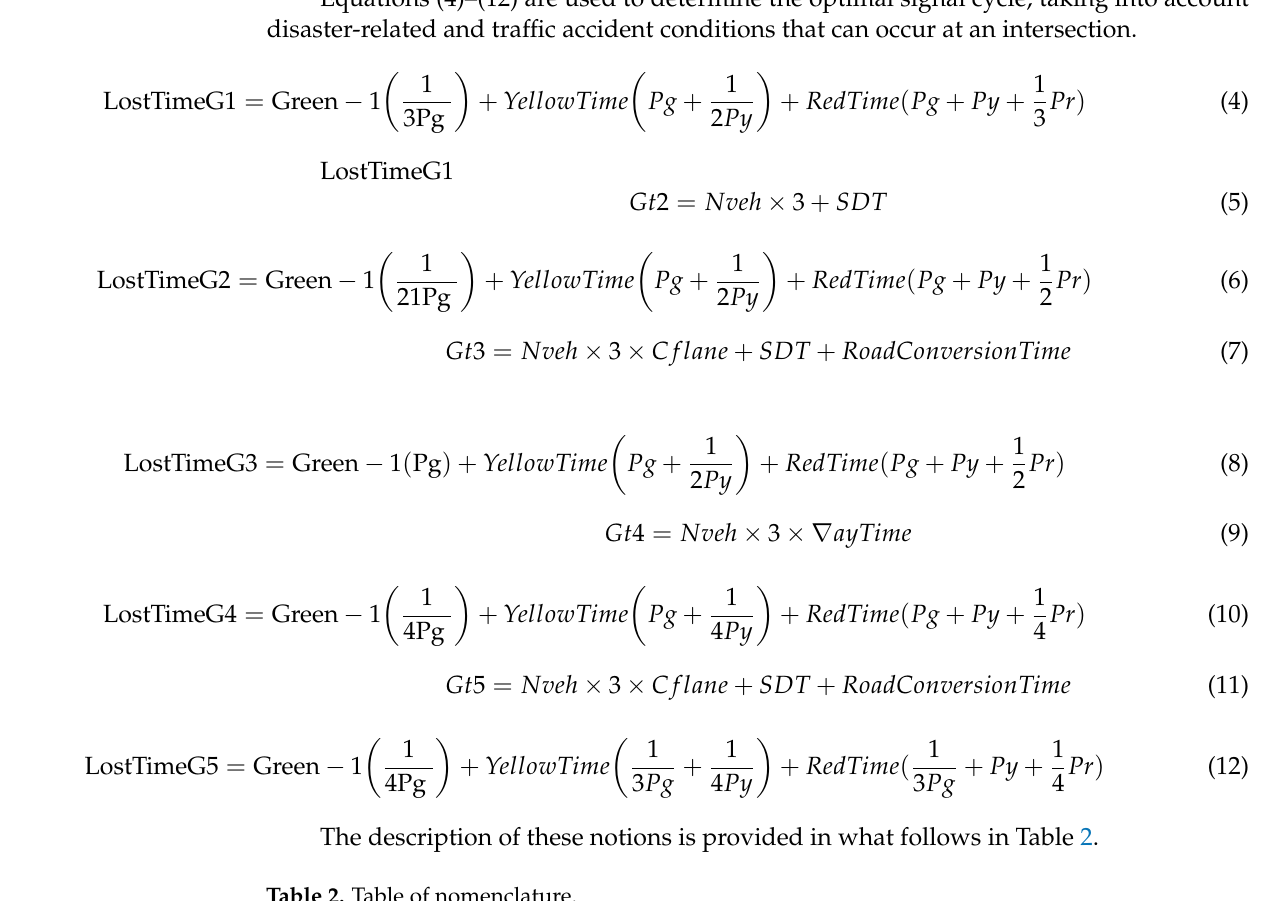
Table 2. Table of